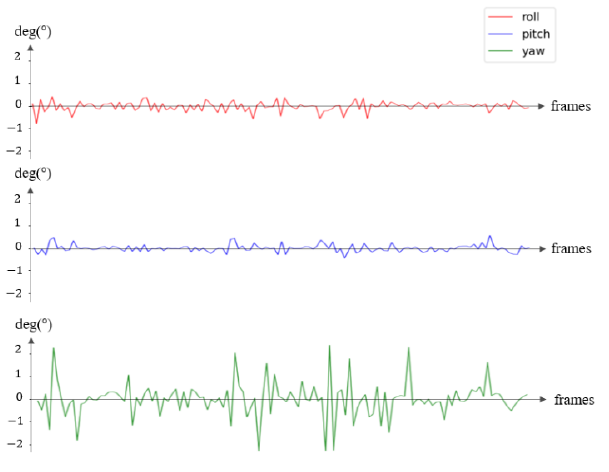
Figure 7 . Rotation